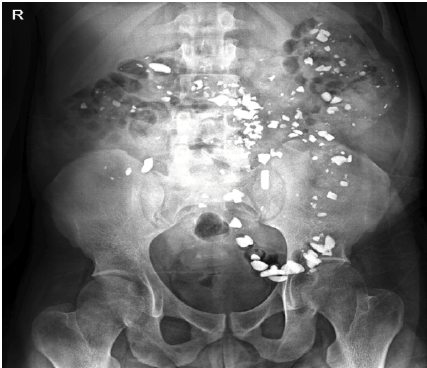
Figure 1: An abdominal radiograph from 6/26/18 showing multiple radiopaque objects in the bowel.